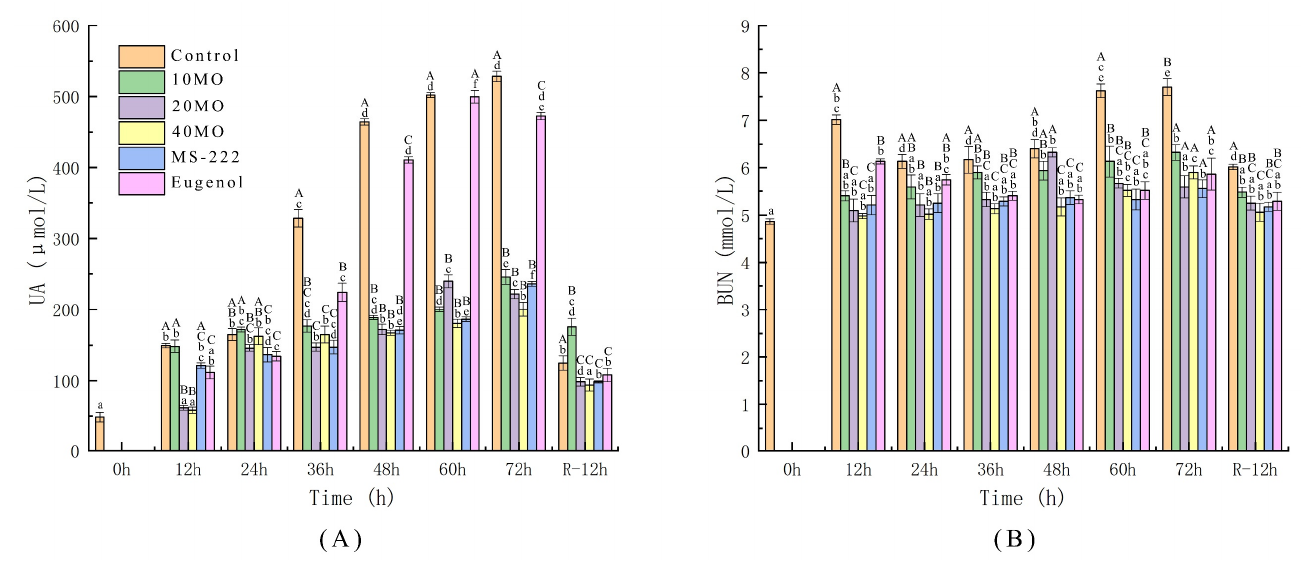
Figure 4. The activity changes in UA ( A ) and BUN ( B ). 10 MO: 10 mg/L MOEO, 20 MO: 20 mg/L MOEO, 40 MO: 40 mg/L MOEO, MS-222: 30 mg/L MS-222, eugenol: 20 mg/L eugenol, control: no agent addition. Vertical bars indicate the standard deviation; Means with different lowercase letters indicate a significant difference between the time intervals within each group ( p ≤ 0.01) while different capital letters indicate significant differences between groups in each time interval ( p ≤ 0.01).